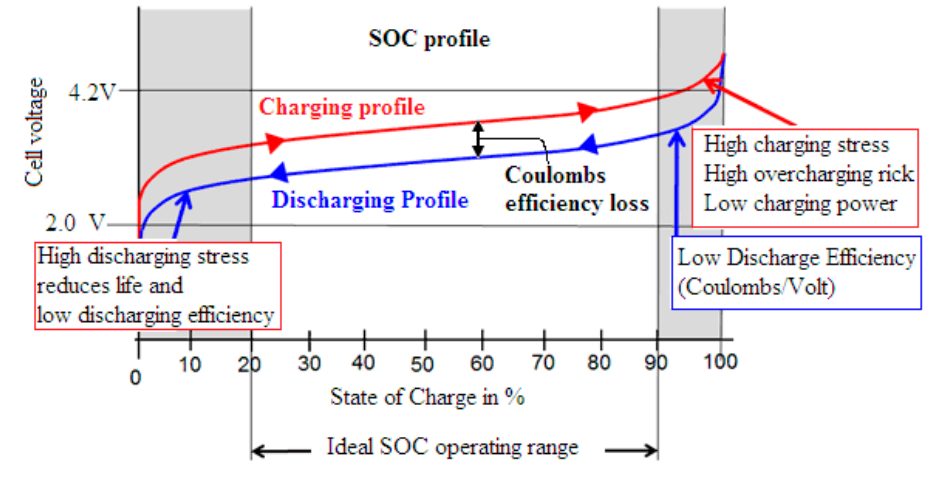
Figure 4. EV Battery SOC profile.